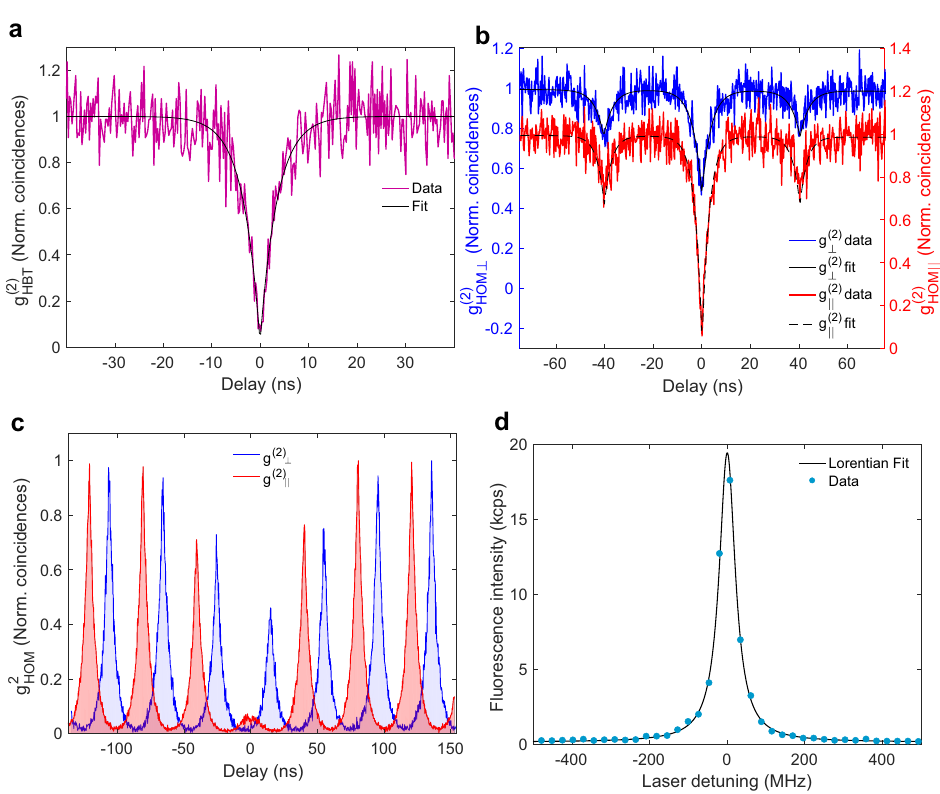
Figure 2. Optical characterization of molecular emission (a)Normalized second-order autocorrelation function of photon coincidences at both Fibered SPADS in continuous wave pumping (b,c) Hong-ou-Mandel Experiment: Histogram of the relative photon arrival time for parallel (red) and orthogonal (blue) polarizations in (b) CW and (c) pulsed excitation. (d) Linewidth measurement by scanning resonant laser across ZPL, exhibiting a lorentzian profile with FWHM = 55 . 1 ± 0 . 5 MHz